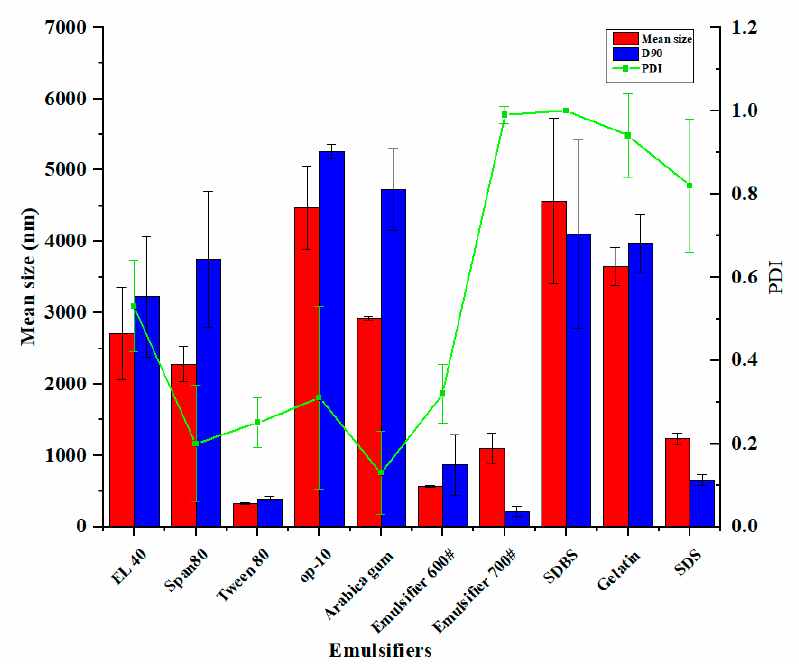
Figure 2. Effects of different emulsifiers on the particle size and PDI of nanocapsules.